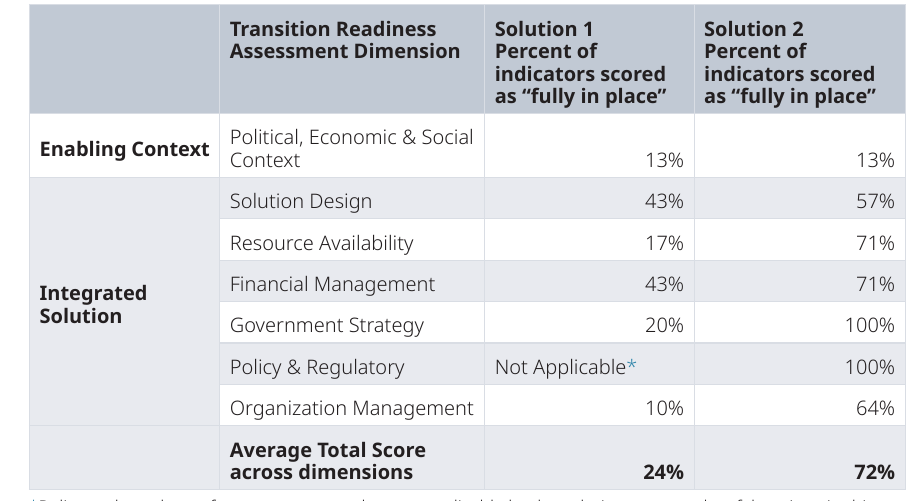
Table 2. Transition readiness assessment scores by